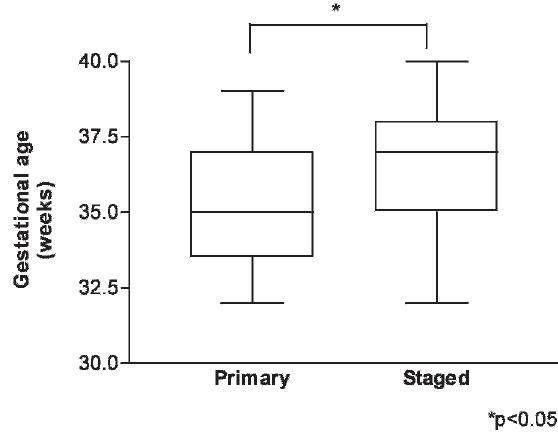
Figure 1 - Newborns in whom primary closure was feasible were born at a significantly lower gestational age (p